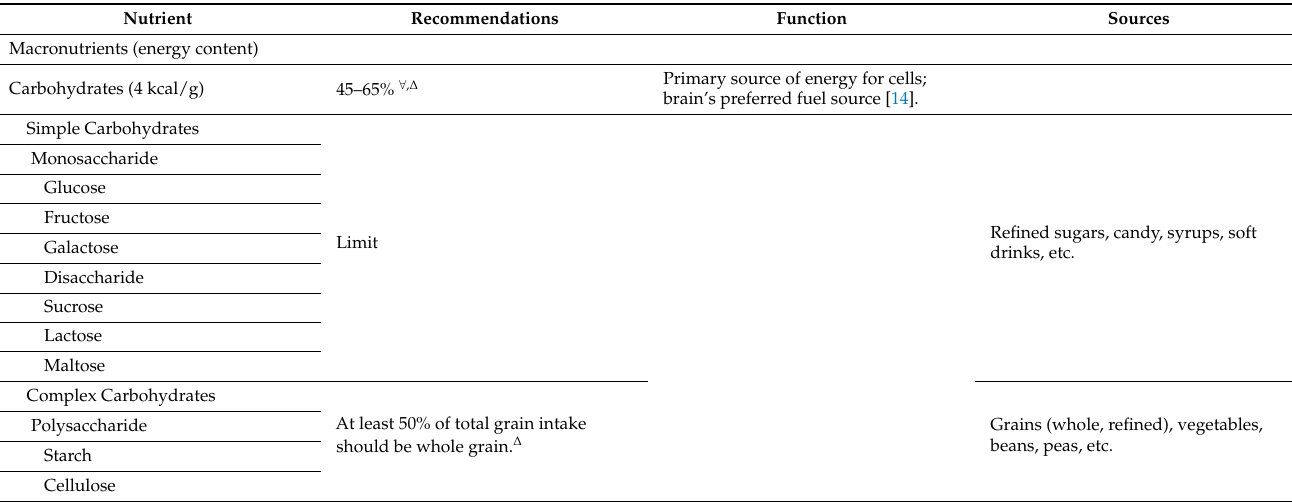
Table 1. Macronutrient and Water Nutrition Education Reference for Health Care Professionals and